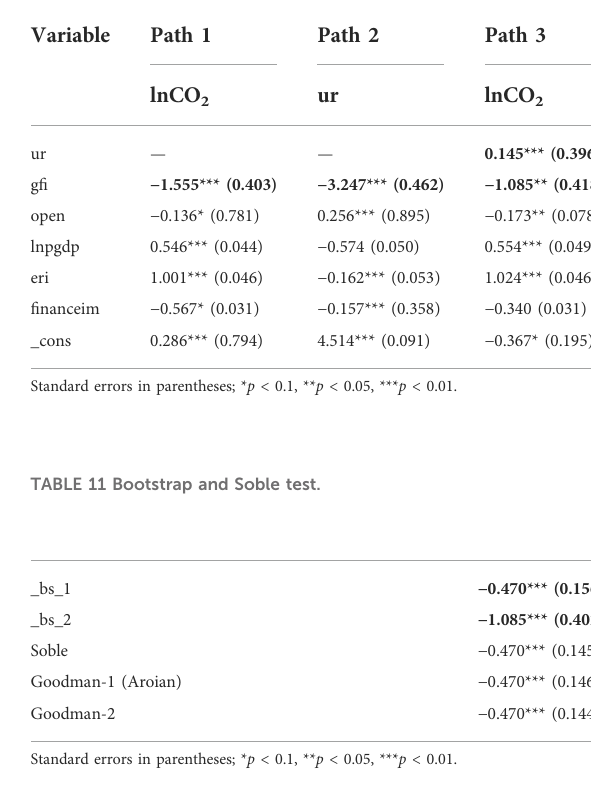
TABLE 10 Results of mediating effect regression analysis.